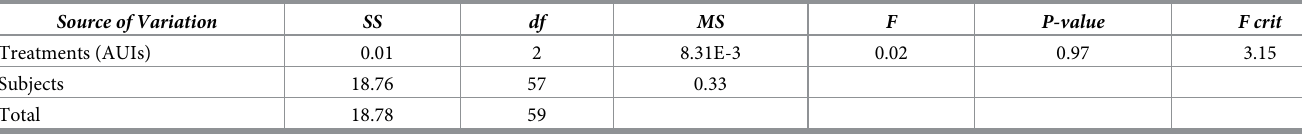
Table 30. One-way ANOVA—Viewpoint #11.